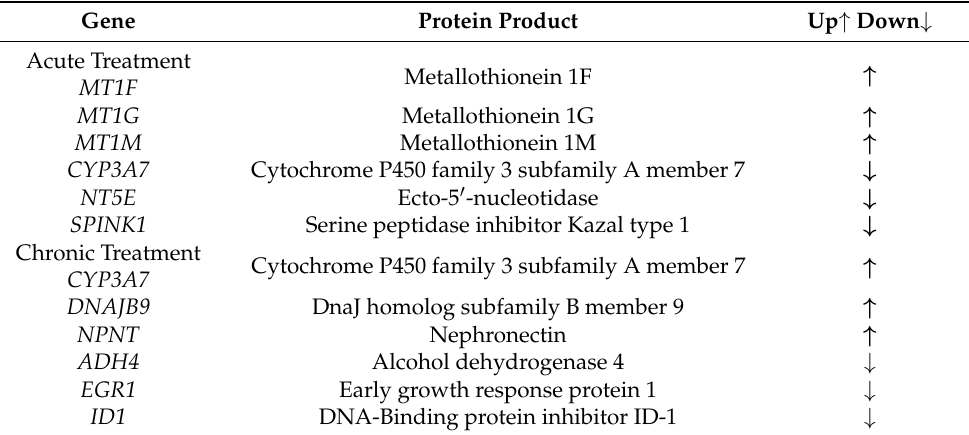
Table 6. PCR-validated differentially expressed genes in HepG2 hepatocarcinoma cells exposed to 0.5 µ M acute or 0.1 µ M chronic CdCl 2 treatment [80]. Gene Protein